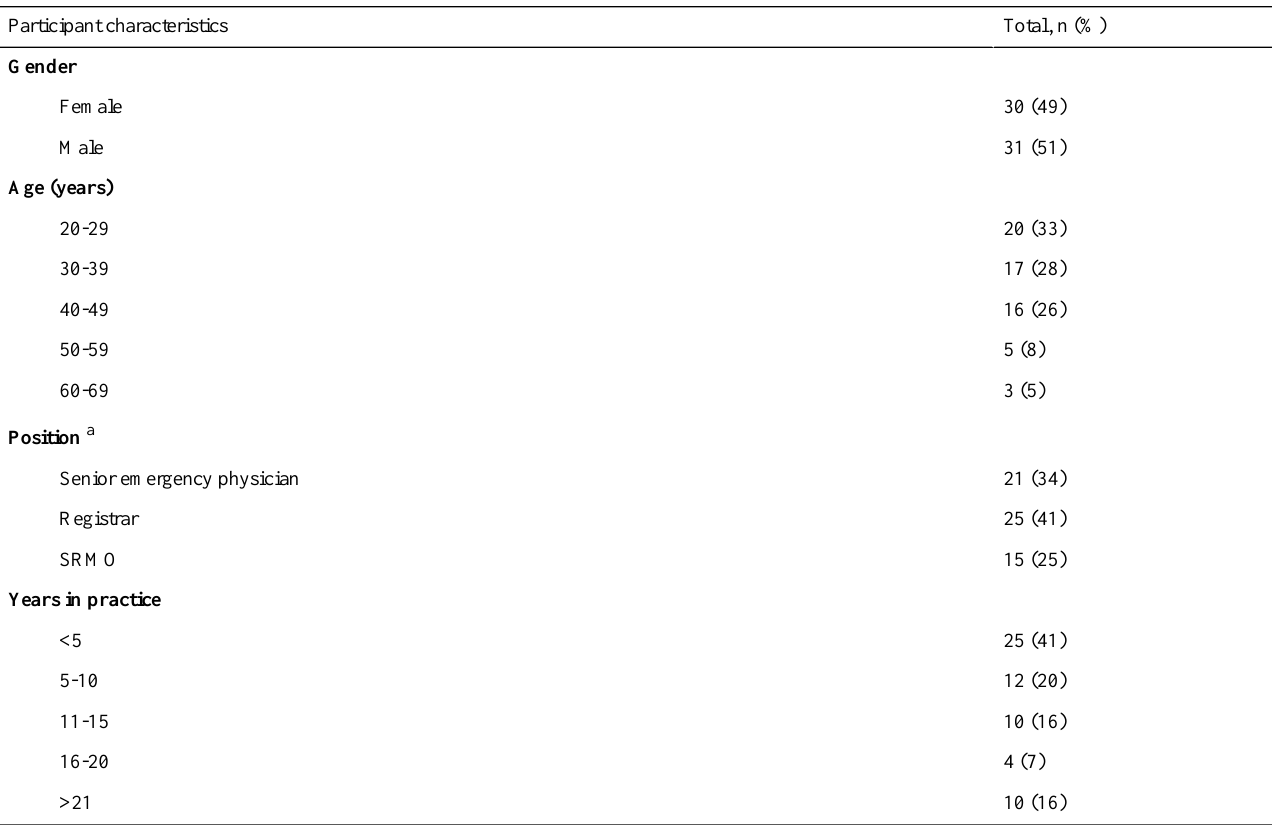
Table 2. Characteristics of emergency physicians from the 2 study hospitals